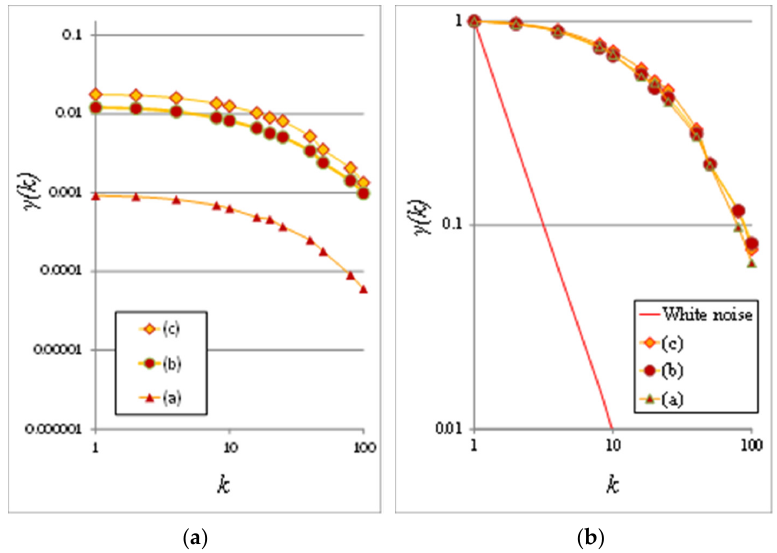
Figure 13. ( a ) Climacograms of the benchmark images; ( b ) standardized climacograms of the benchmark images. A standardized climacogram is not helpful to evaluate the range of the evolution of clustering but is helpful to estimate the curves’ slope for further analysis. Source: [39]. In Figure 14a,b, each climacogram is represented by its corresponding integral, per- mitting the evaluation of the rate of the alteration of clustering through time.